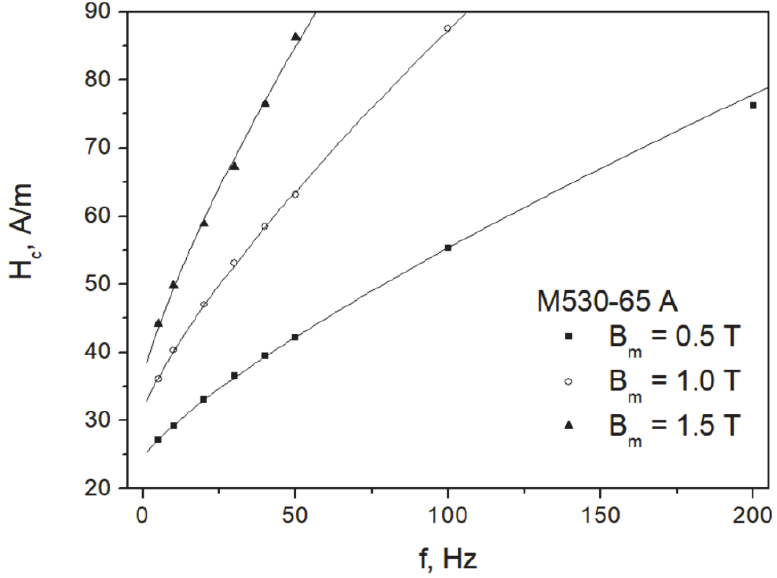
Figure 6. Fractional power law fit of the dependence H c = H c ( f ) for the thicker steel grade.